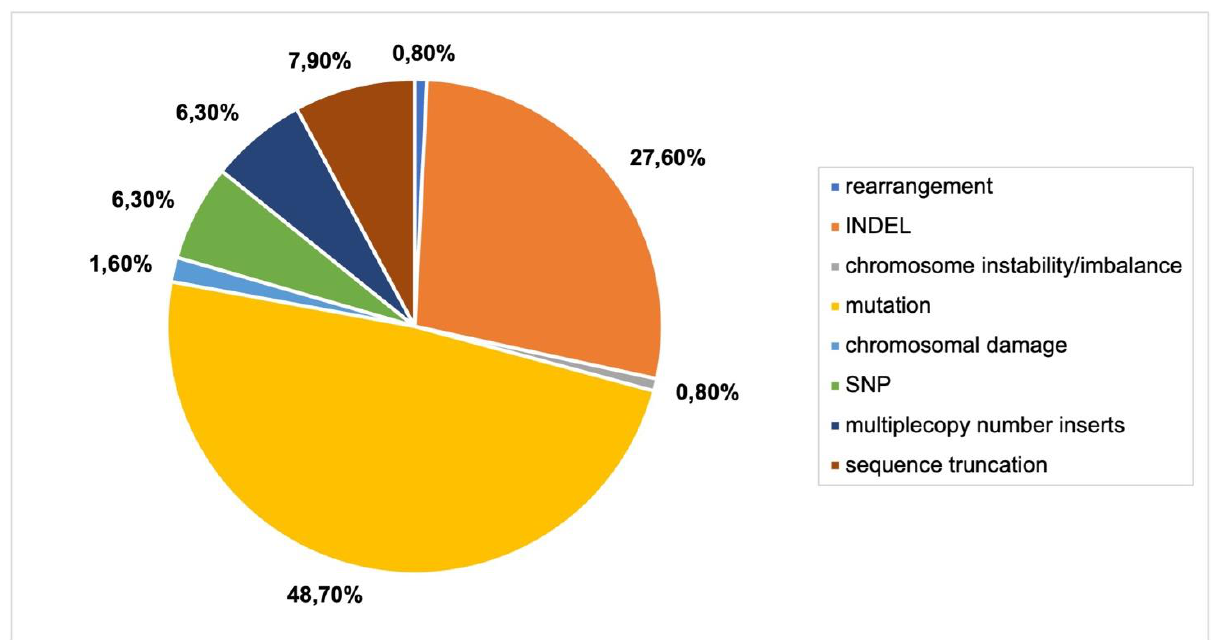
Figure 6. Genomic outcomes from CRISPR-Cas9 via Agrobacterium . N = 22 articles. Colors in graph refer to legend in Figure 4A.